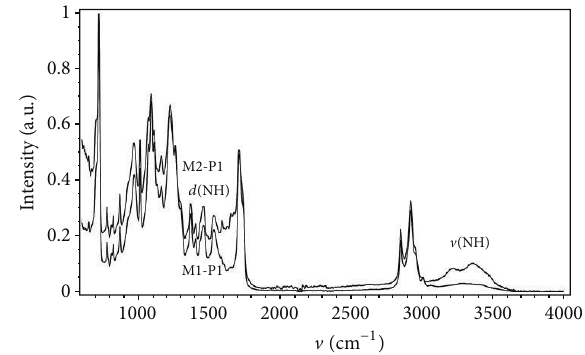
Figure 6: ATR spectra from samples M1 (bottom) and M2 (top) measured in areas of reduced contamination (point 1 in Figure 5).